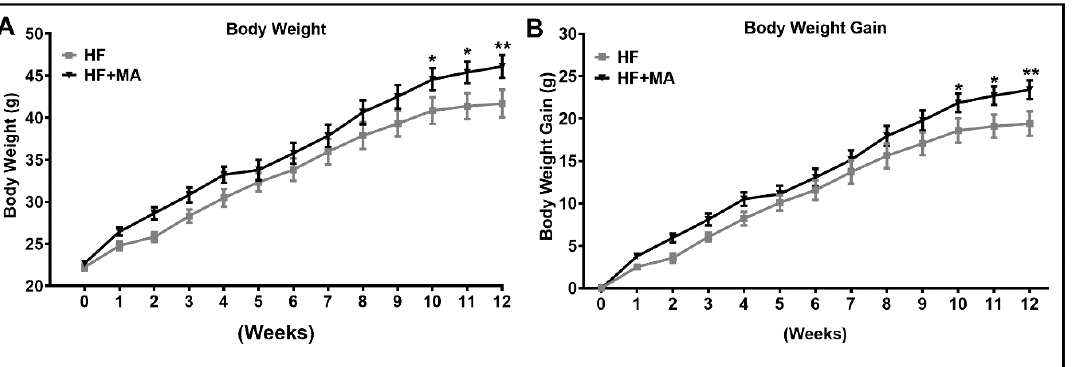
Figure 1. Effect of dietary myristic acid on body weight. Wild-type C57BL/6 mice were fed a HF diet supplemented with MA for 12 weeks. Weekly body weight ( A ) and body weight change from baseline ( B ) were recorded during the feeding period. Values are expressed as mean ± SEM of 8 mice per group. * p < 0.05 and ** p < 0.01 vs. HF. HF, high fat; HF+MA, high fat + myristic